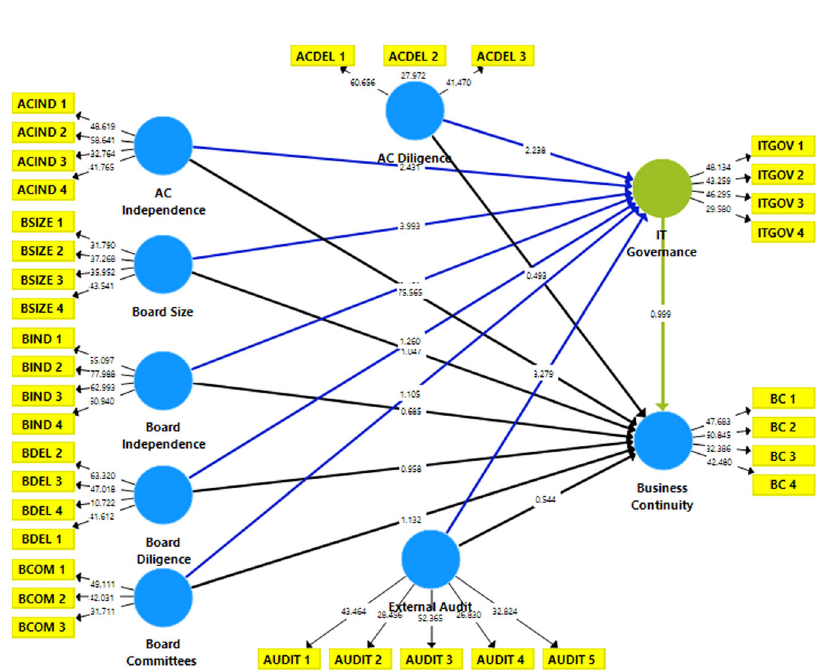
Fig. 4 Structural equation model-direct effect. This fi gure displays the study variables ’ hypothesised or predicted structural approach. It provides a direct effect model for the in fl uence of the explanatory variables represented by CGC and ITG on the BC predicted